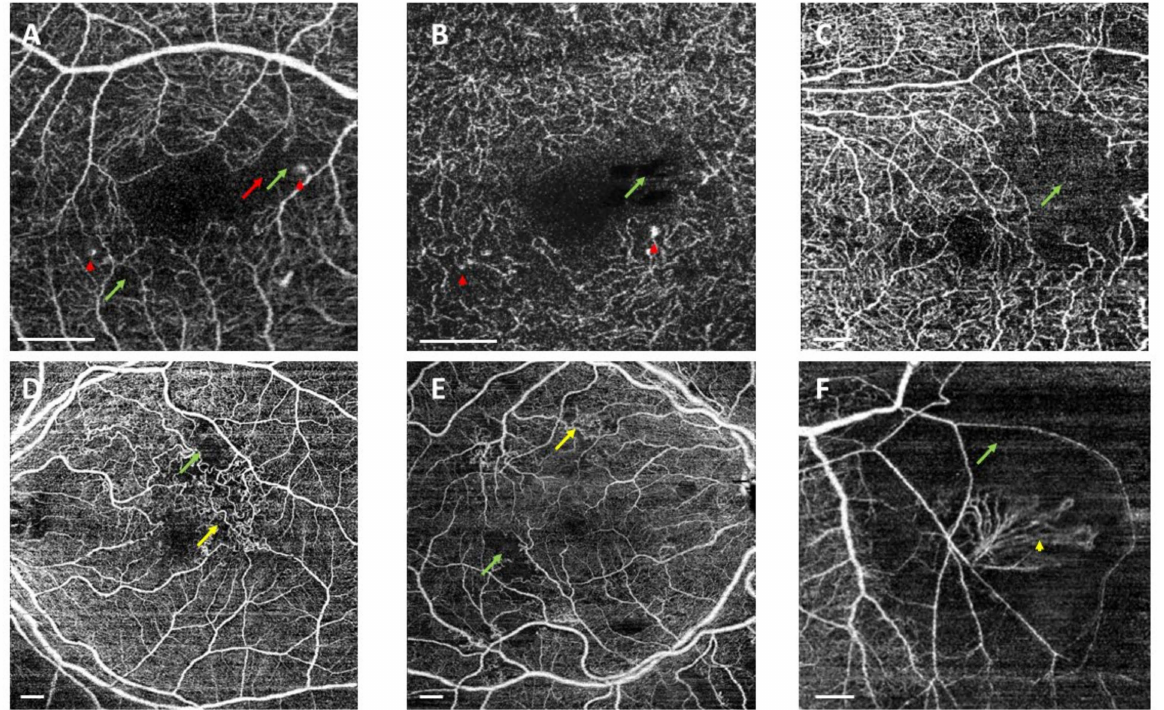
Figure 3. Swept source optical coherence tomography angiography (SS-OCTA) showing representa- tive examples of OCTA findings in diabetic patients. OCTA was acquired using DRI-Triton SS-OCT (Topcon, Tokyo, Japan). ( A , B ) Superficial (SCP) and deep capillary plexuses (DCP) in 3 × 3 mm scans. Figure 3C shows SCP in a 6 × 6 scan. ( D , E ) The SCP in a 9 × 9 scan and 3F SCP in a 6 × 6 scan protocol. ( B ) An irregular foveal avascular zone (red arrows) and microaneurysms (red arrowheads) in the superficial and deep capillary plexuses. ( C ) Nonperfusion areas in the temporal area (green arrows). ( D , E ) Areas of impaired perfusion associated with intraretinal microvascular abnormalities (yellow arrows). ( F ) Retinal neovascularization elsewhere (yellow arrowhead). Scale bar represents 1